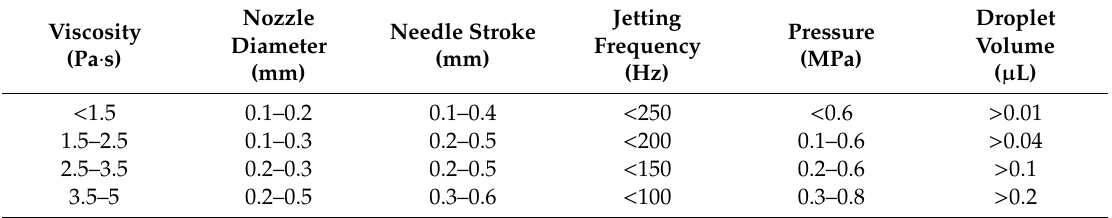
Table 2. The recommended parameter value ranges for liquids with di ff erent viscosities.